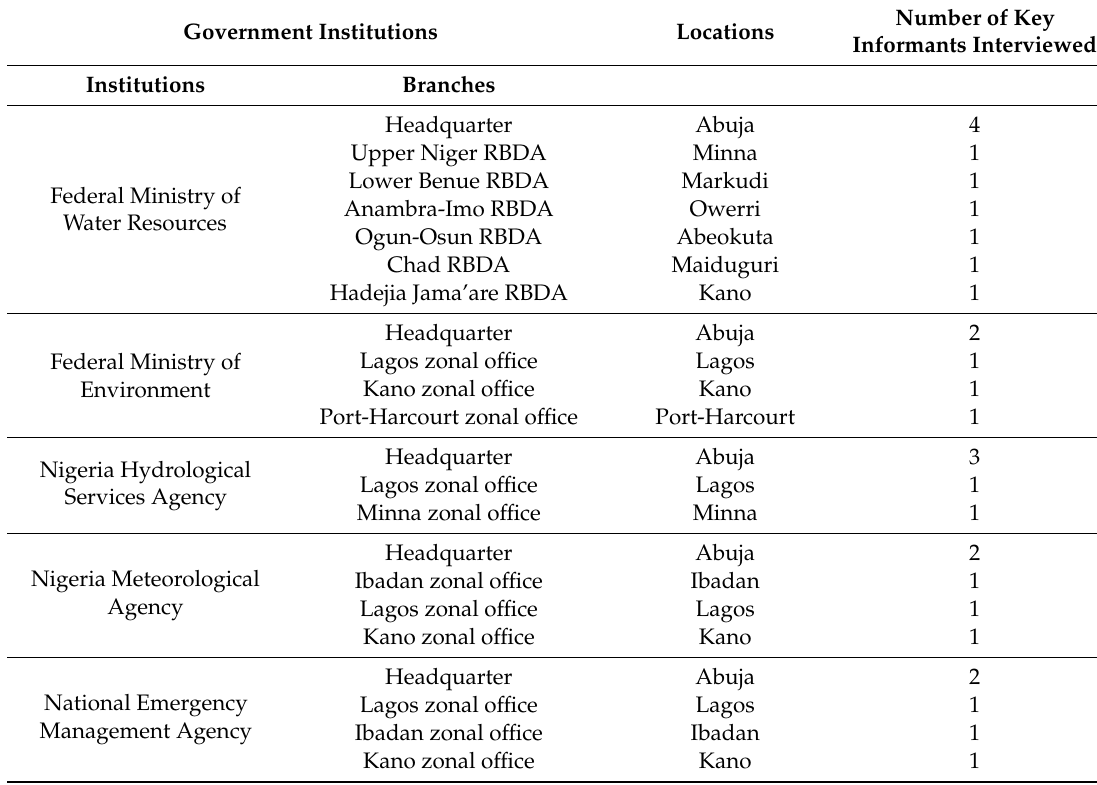
Table 2. List of interviewees and their a ffi